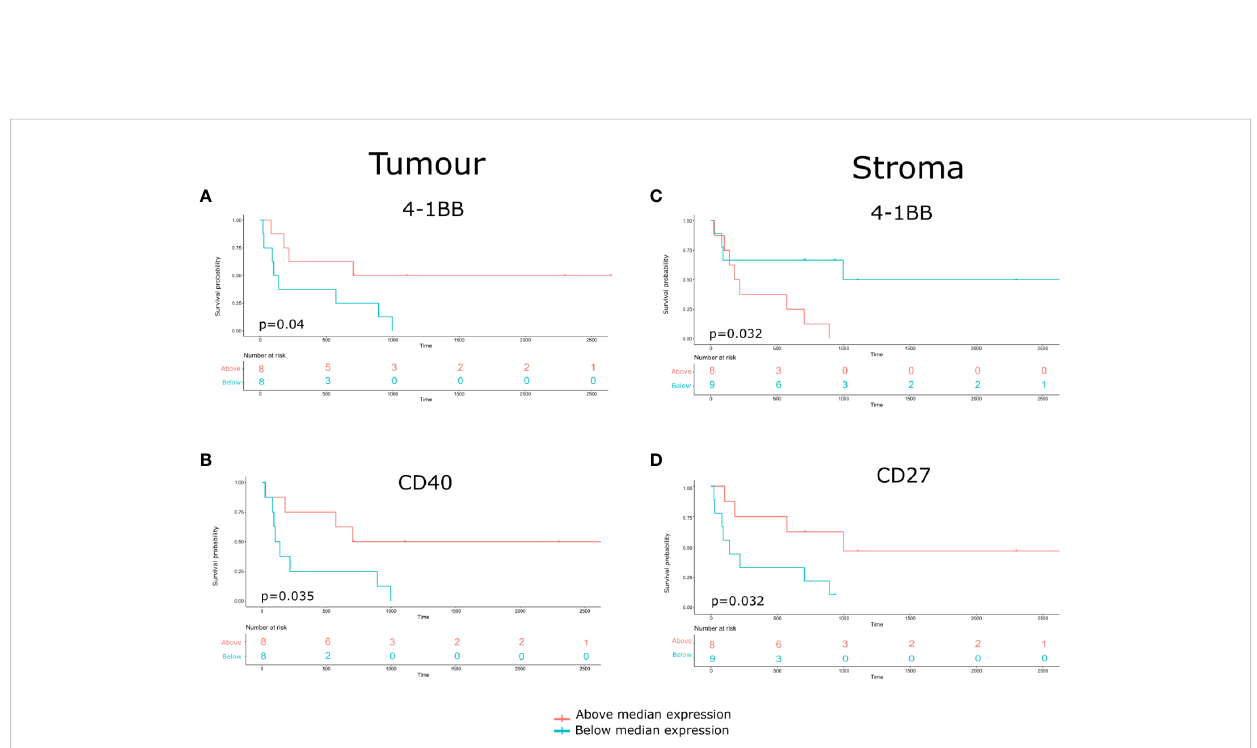
FIGURE 8 Identi fi cation of Compartmentalized protein enrichment with survival associations. (A, B) The Kaplan-Meier survival analyses conducted on the tumor protein biomarker expression. (C, D) The Kaplan-Meier survival analyses conducted on the stromal protein biomarker expression. The p-value of the curves is calculated using the log-rank